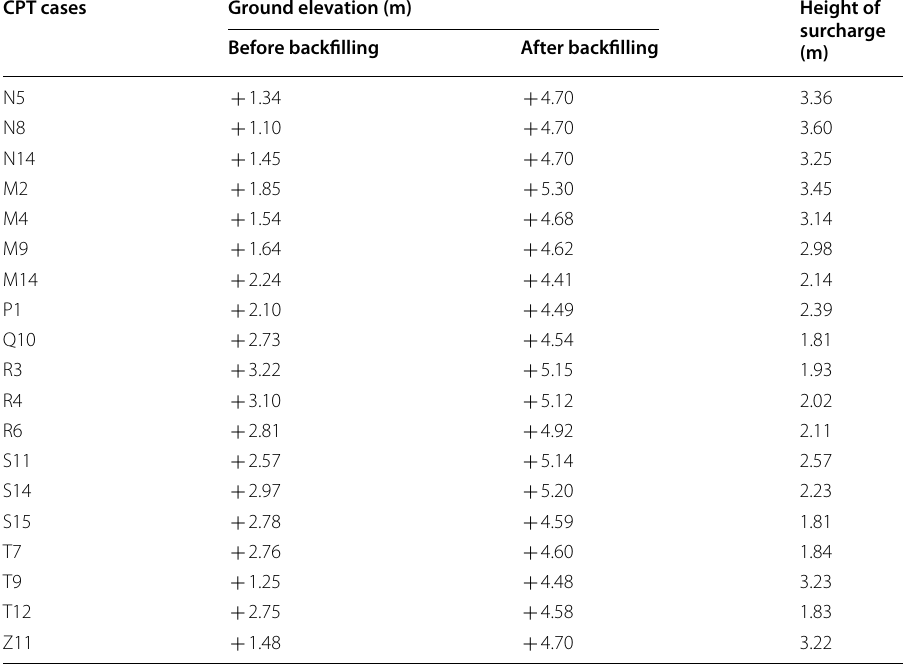
Table 2 Ground elevations of pre and post CPTs CPT